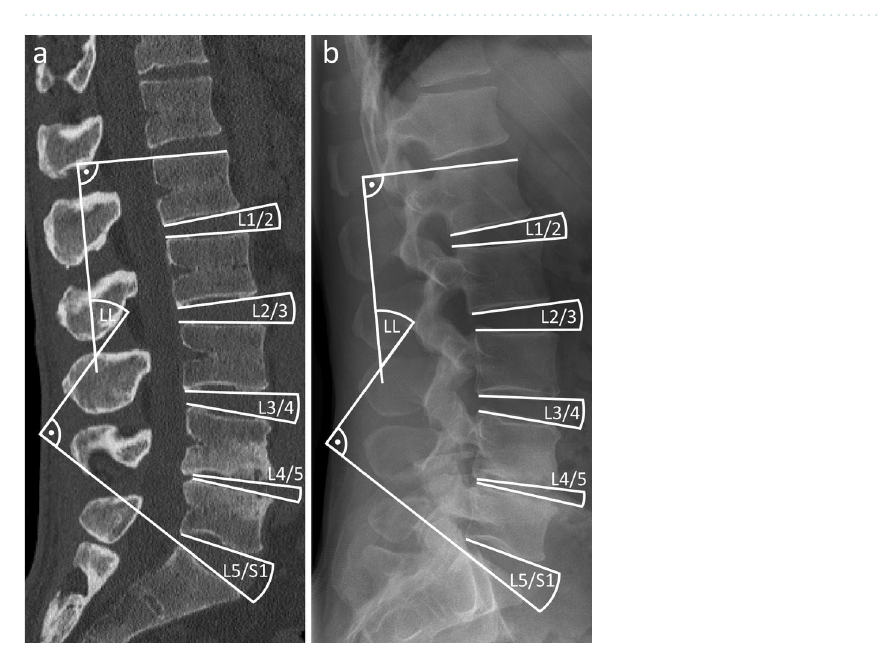
Figure 1. Creation of CT-based 3D geometry. ( a ) CT scan ( b ) segmentation masks ( c ) automatically generated triangle-based surface mesh ( d ) triangle mesh after uniform remeshing and smoothing.